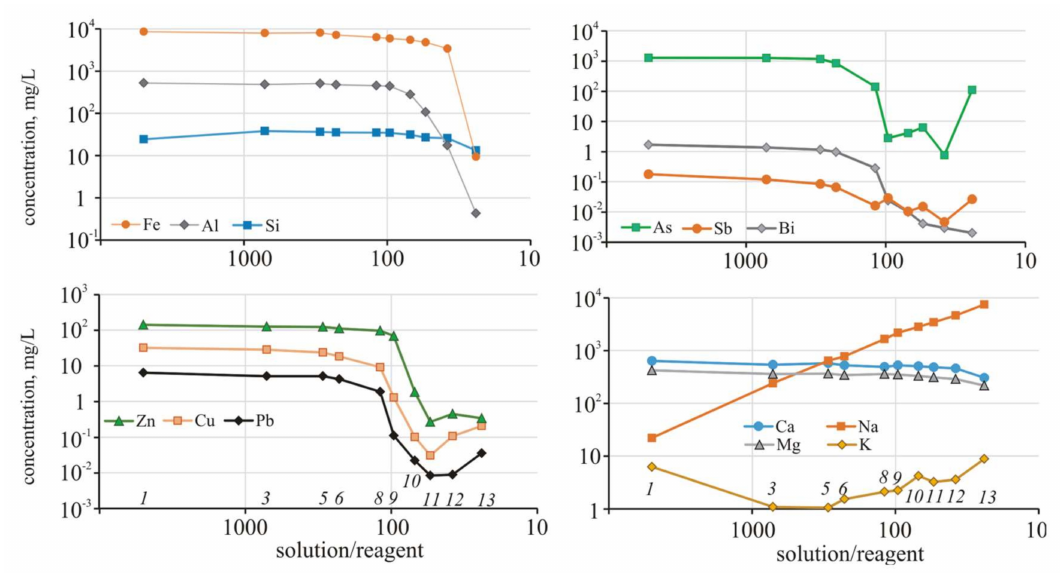
Figure 6. Changes in the elemental concentrations during the experiment with Na 2 S.